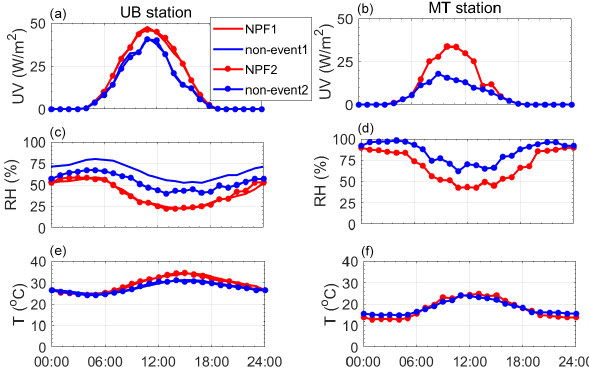
Figure 10. (a, b) Diurnal pattern of solar radiation (UV, Wm − 2 ), (c, d) Temperature ( T , ◦ C), and (e, f) Relative humidity (RH, %), at UB (a, c, e) and MT (b, d, f) stations on both NPF event and non-event days. Time resolutions for all data points here were 1h. ‘NPF1” and “non-event1” refer to NPF event and non-event